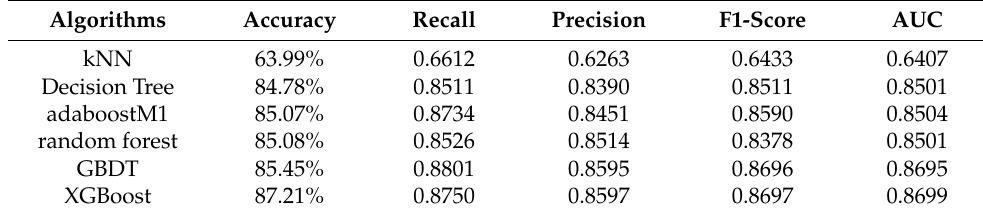
Table 1. Overall result performance of all algorithms (13 features).